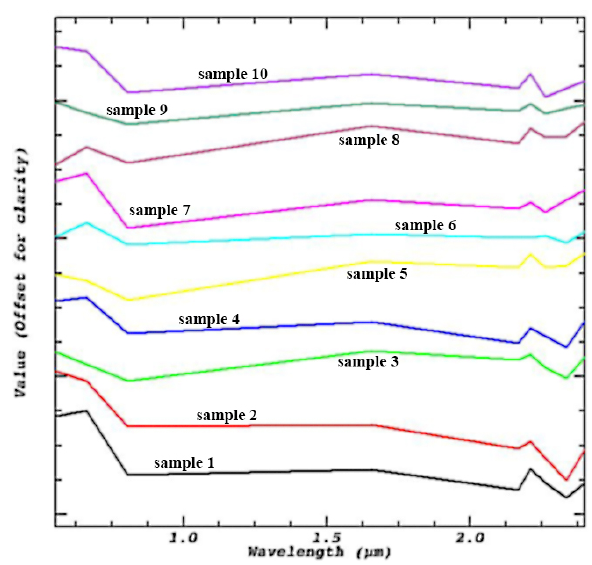
Figure 4. Z-Profile related to the locations of sampling obtained from ASTER image.